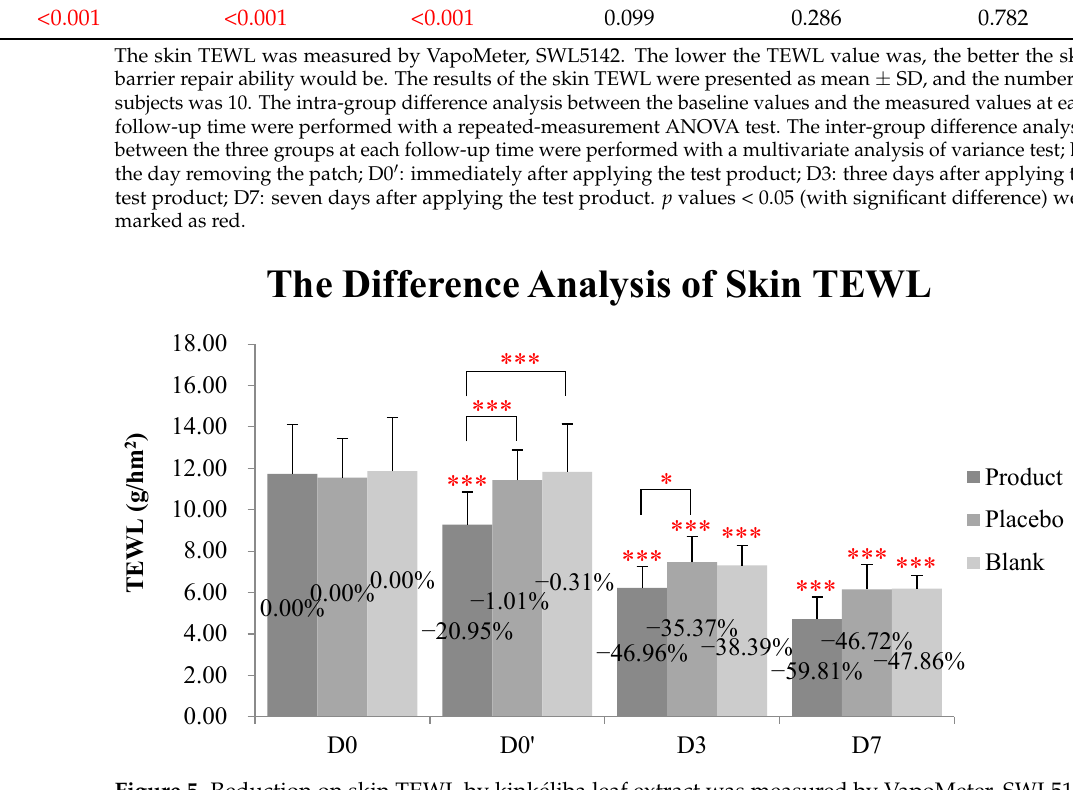
Figure 5. Reduction on skin TEWL by kinkéliba leaf extract was measured by VapoMeter, SWL5142.